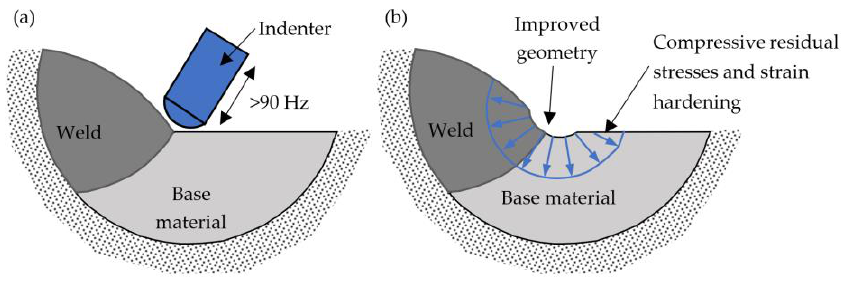
Figure 2. HFMI treatment of weld toe: ( a ) HFMI treatment ( b ) fatigue improvement parameters.